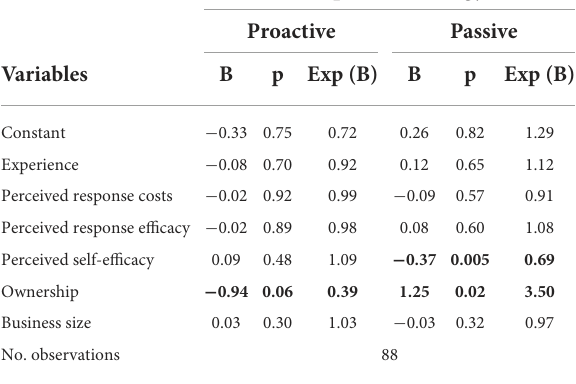
TABLE 11 Influence of various factors on adaptation behavior (data: businesses in Germany damaged by pluvial floods